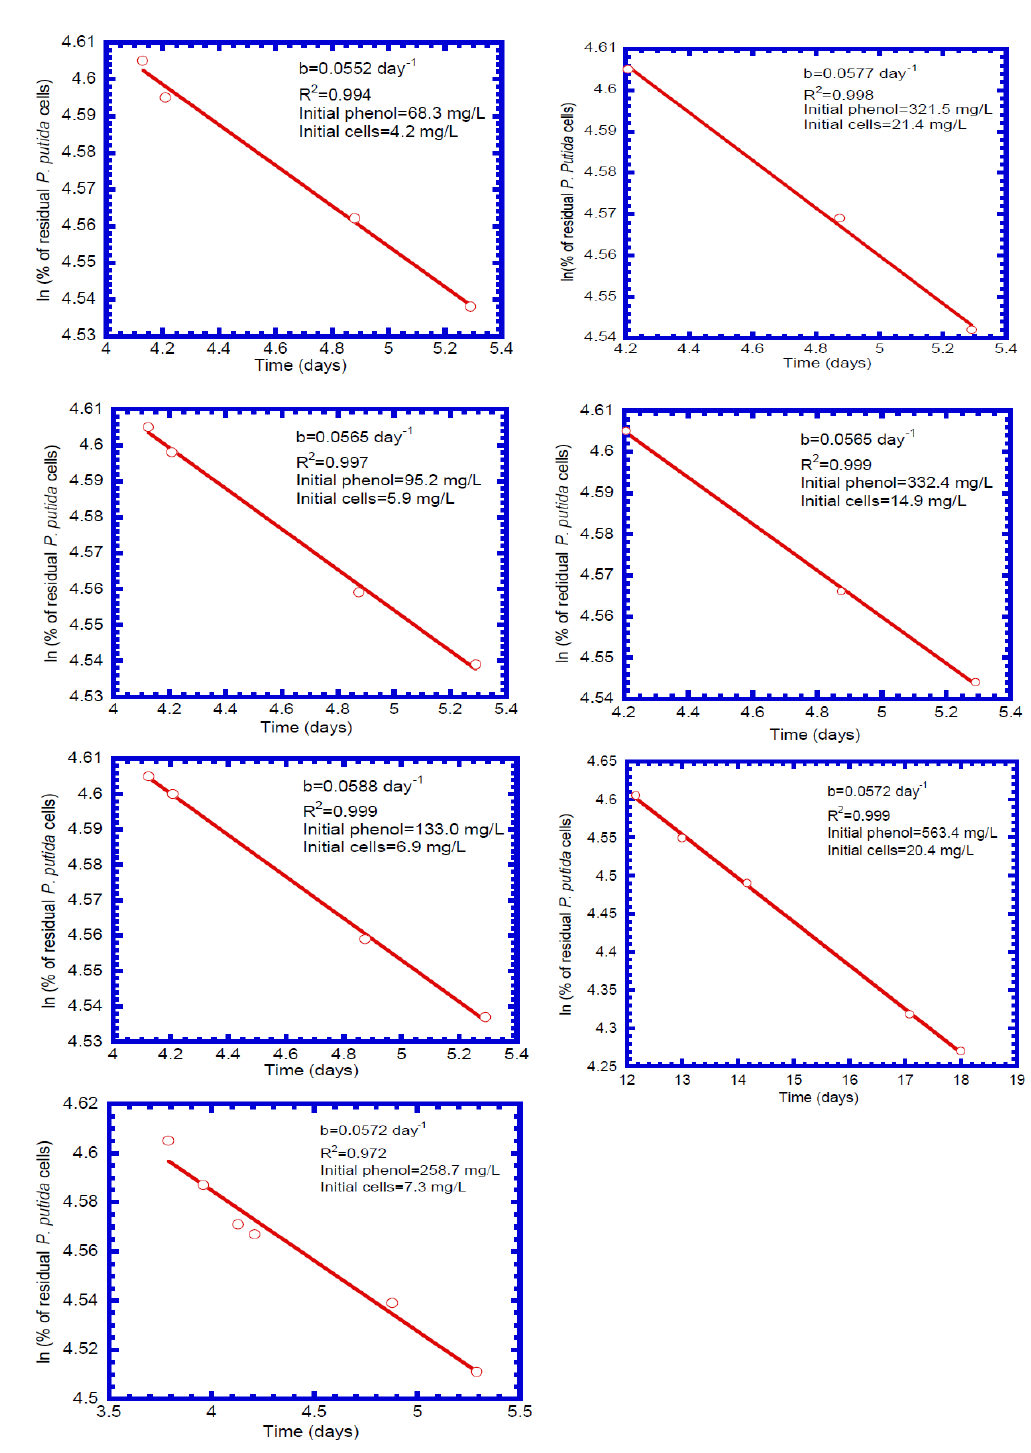
Figure 10. Batch experiments to evaluate the decay coefficient ( b ) for P. putida cells.